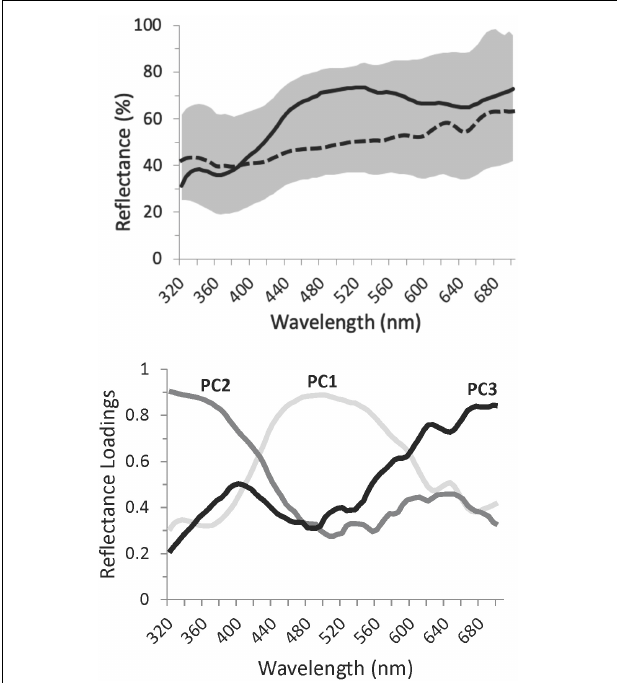
FIGURE 2 | Variation in Rüppell’s weaver eggshell ground color (though influenced to some extent by maculation), in terms of spectral reflectance curves. Top: Range of reflectance in the sample, and two representative egg spectra. The shaded area defines the range of reflectance, across the bird-visible spectrum, of the ground color of 63 eggs in 26 clutches, three or fewer days after laying. The top and bottom edges of this shaded area represent extremes of brightness. To the extent that eggs exhibited chromatic variation in ground color, they were of a bluish hue, indicated by a reflectance hump between 400 and 650 nm, peaking around 500 nm. Extremes of blue chroma in the sample are exemplified by the solid curve (high chroma) and the dashed curve (low chroma). The tendency of the shaded area and the lines to increase in reflectance above about 600 indicates a small degree of reddish-brown in some of the eggs. In many cases this signal resulted from an inability to avoid fine spots when taking spectral measurements of ground color. Bottom: Factor loadings from a Principal Components Analysis of reflectance spectra of all study eggs, indicating three uncorrelated axes of variation: broadly speaking, in blue–green (PC1, explaining 30.8% of the variance), UV (PC2, explaining 23.0% of the variance), and reddish-brown (PC3, explaining 22.6% of the variance). The loading for a particular wavelength indicates the contribution of that wavelength to the respective PC. These curves represent a varimax rotation of the principal components, which distributes variation across the PCs and, in this case, highlights chromatic